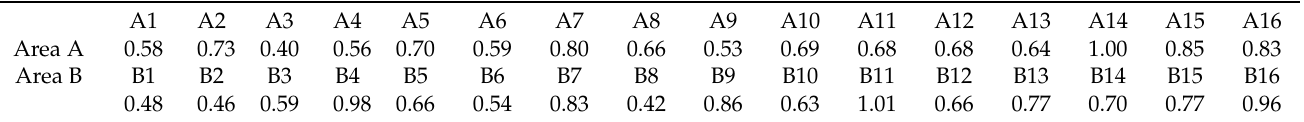
Table 2. Laboratory results for the AGB in kg/m 2 . For location of samples see Figure